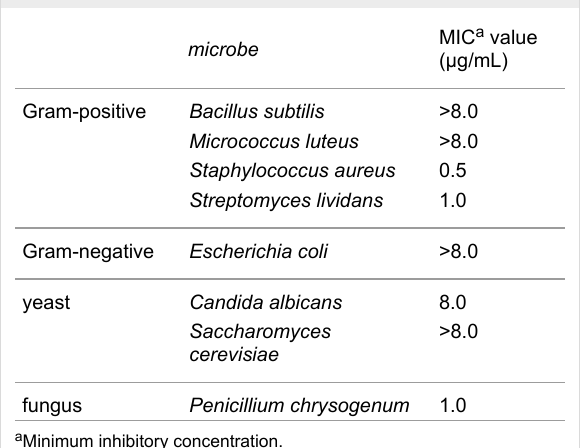
Table 2: Antimicrobial activity of sacrolide A ( 1